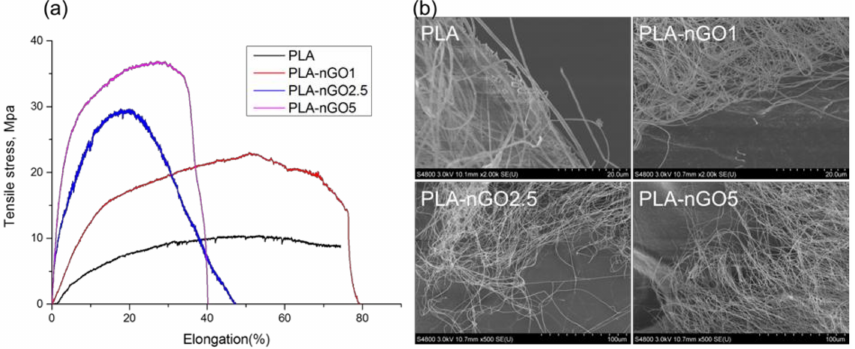
Figure 4. ( a ) Stress-strain curves of PLA, PLA-nGO1, PLA-nGO2.5 and PLA-nGO5 fibers; ( b ) SEM images of PLA, PLA-nGO1, PLA-nGO2.5, and PLA-nGO5 fibers after tensile